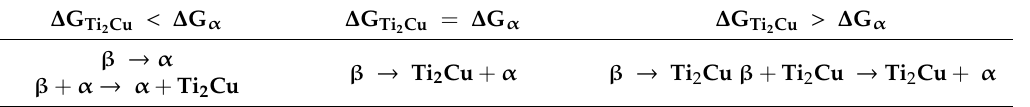
Table 2. Reaction equations for stable phases and microstructural